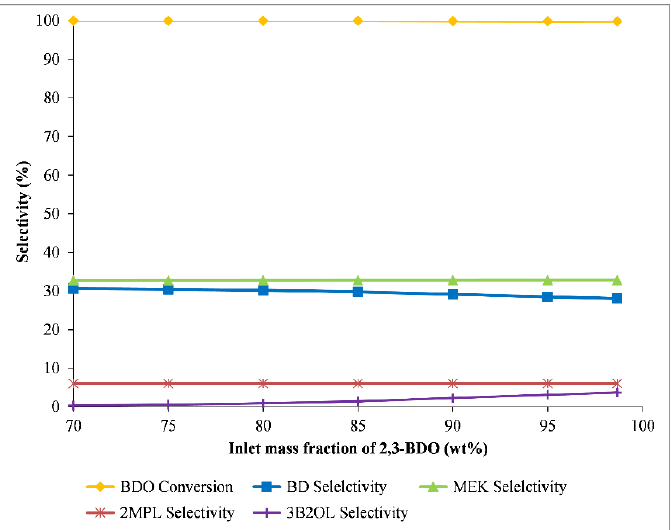
Figure 10. The influence of feed composition on reactor performance.